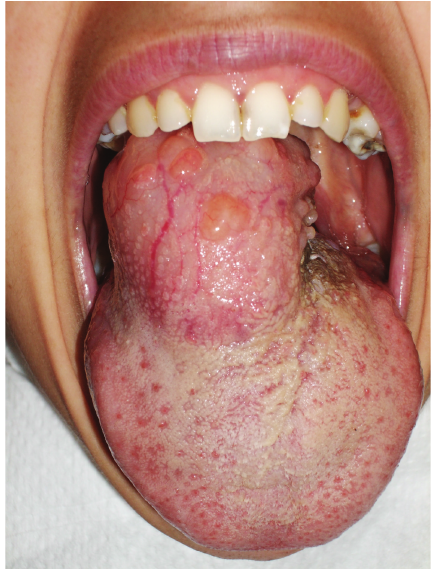
Figure 1: Oral cavity examination showing a large mass of the tongue base.